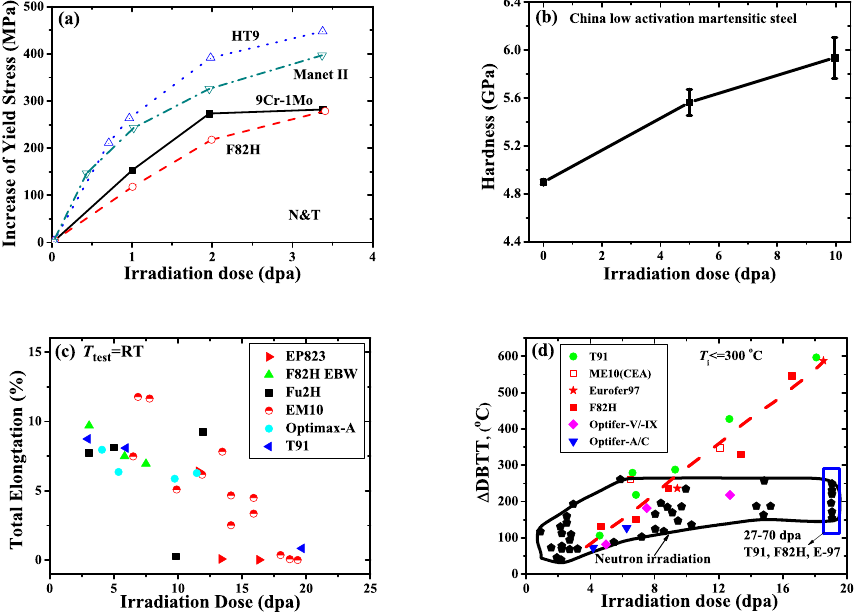
Figure 1. (color online) ( a ) Increase of the yield stress as a function of irradiation dose for reduced activation and conventional steels irradiated and tested at 698 K. (Reprinted with permission from [4]. Copyright 2000 by Elsevier.) ( b ) Hardness as a function of irradiation dose for nanocrystalline CLAM steels irradiated by Xe ions at room temperature (Reprinted with permission from [25]. Copyright 2014 by Elsevier.) ( c ) Total elongation as a function of irradiation dose for ferritic/martensitic steels when irradiated at 623 K in STIP and 598 K in BOR60. (Reprinted with permission from [26]. Copyright 2011 by Elsevier.) ( d ) Change of DBTT as a function of irradiation dose for ferritic/martensitic steels irradiated in fission reactors and STIP. (Reprinted with permission from [26]. Copyright 2011 by